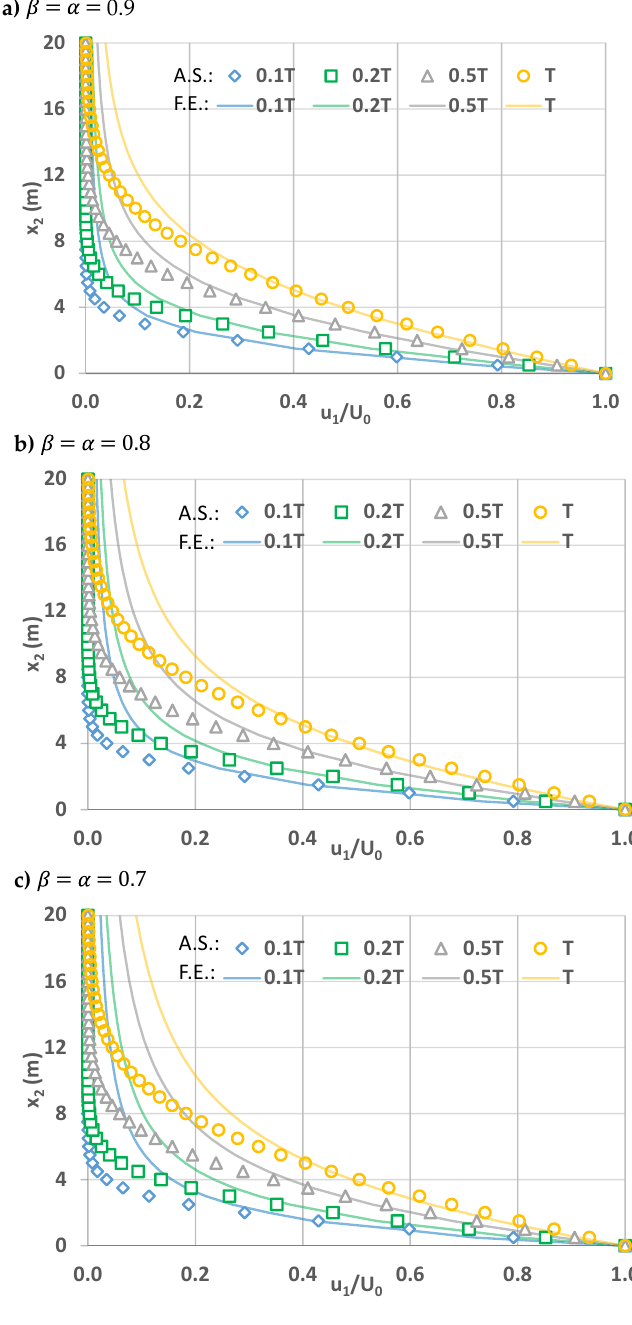
Figure 7. Velocity profiles of x 1 direction velocity u1 normalized by boundary velocity U 0 when space and time fractional derivative powers are equal, ( a ) α = β = 0.9, ( b ) α = β = 0.8, ( c ) α = β = 0.7. Solid lines correspond to simulations by the fractional governing equation (F.E.) when time t = 0.1 T, 0.2 T, 0.5 T¸ T. Shapes (diamond, square, triangle, and circle) represent the analytical solutions (A.S.) of the conventional governing equation at corresponding